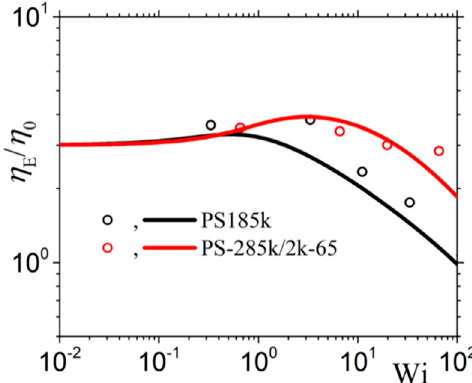
Figure 12. Comparison of the model predictions with the experimental measurements of Costanzo et al. [16] for the steady uniaxial extensional viscosity. Same parameter values as in Figure 11 but in all cases ξ = 0.